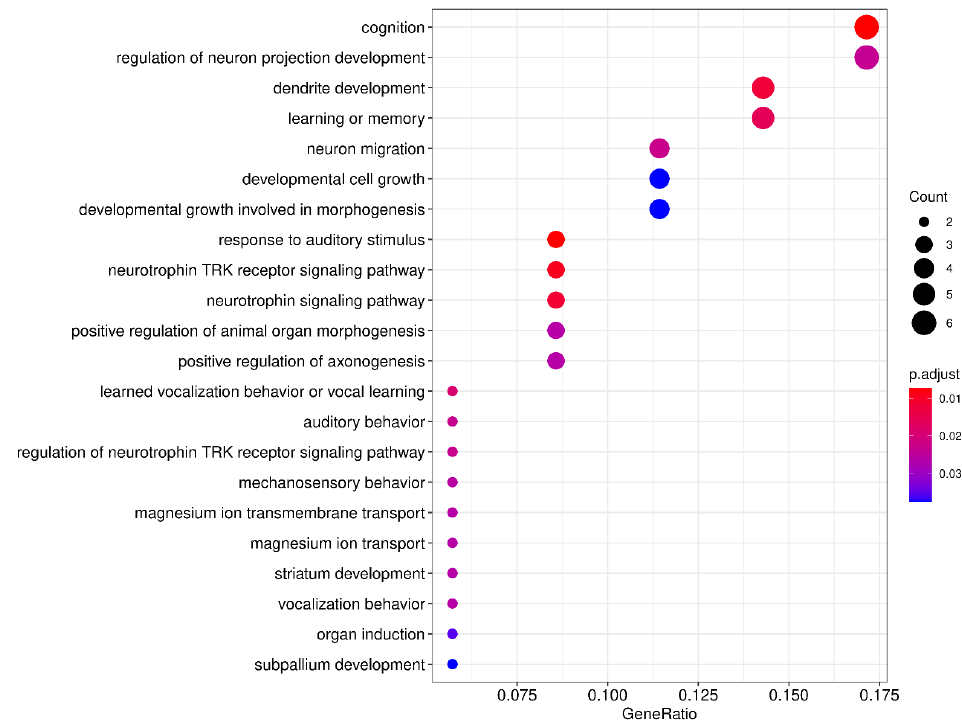
Figure 2. Top gene ontology (GO) terms (Biological Processes; y -axis) significantly enriched in the Scheme 1. The figure was generated in R using ClusterProfiler . Count: Number of genes per GO term (gene-set), GeneRatio: Number of genes per GO term (gene-set) to the total number of queried genes ( n = 36), p.adjust: Adjusted p -value using the Benjamini– Hochberg correction for multiple comparisons ( p < 0.05). Data accompanying this figure are available in the Appendix A (Table A1).